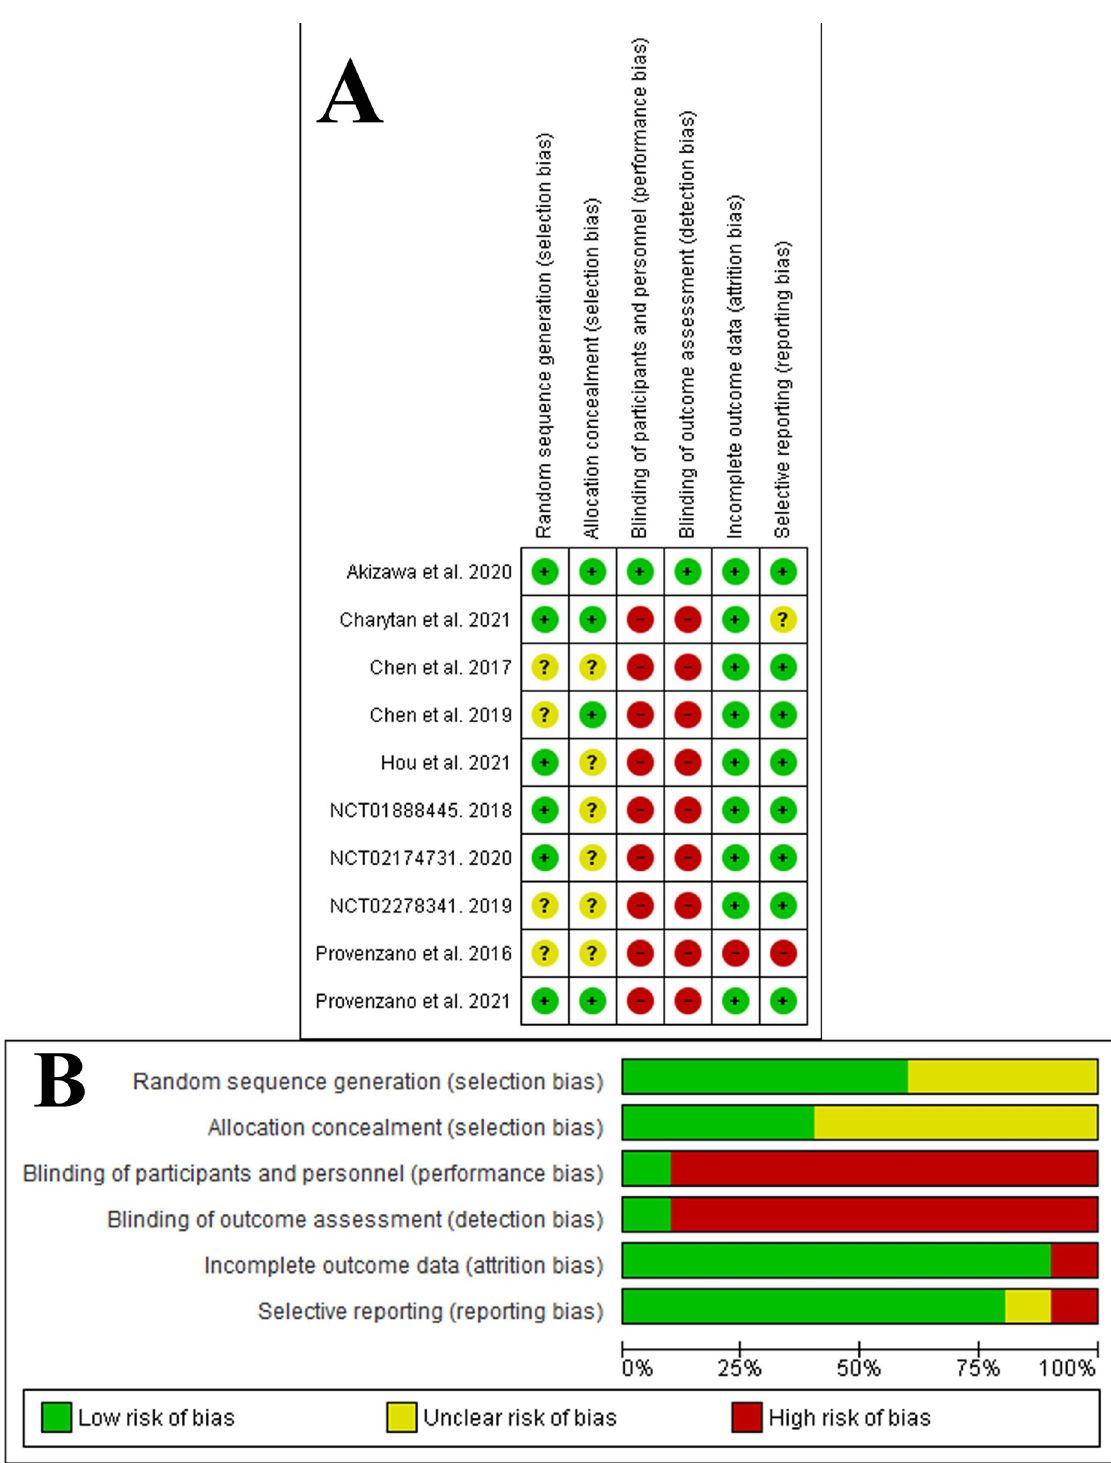
Fig 2. Risk of bias assessment. A: Risk of bias summary: review authors’ judgments about each risk of bias item for each included study. The items are scored (+) low risk; (-) high risk; (?) some concerns. B Risk of bias graph: review authors’ judgments about each risk of bias item presented as percentages across all included